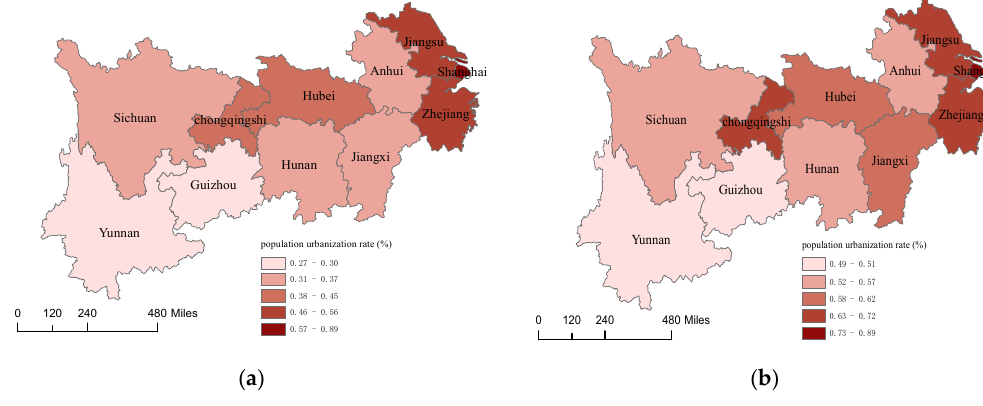
Figure 3. Population urbanization of YREB: ( a ): 2001; ( b ): 2019. The results show that land urbanization has a negative impact on CLUE regardless of whether control variables are included. It indicates that for each percent increase in the expansion of urban spatial scope in the YREB, CLUE decreases by 0.06%. As is shown in Figure 4, before 2011, the land urbanization rate of megacities and central cities in YREB